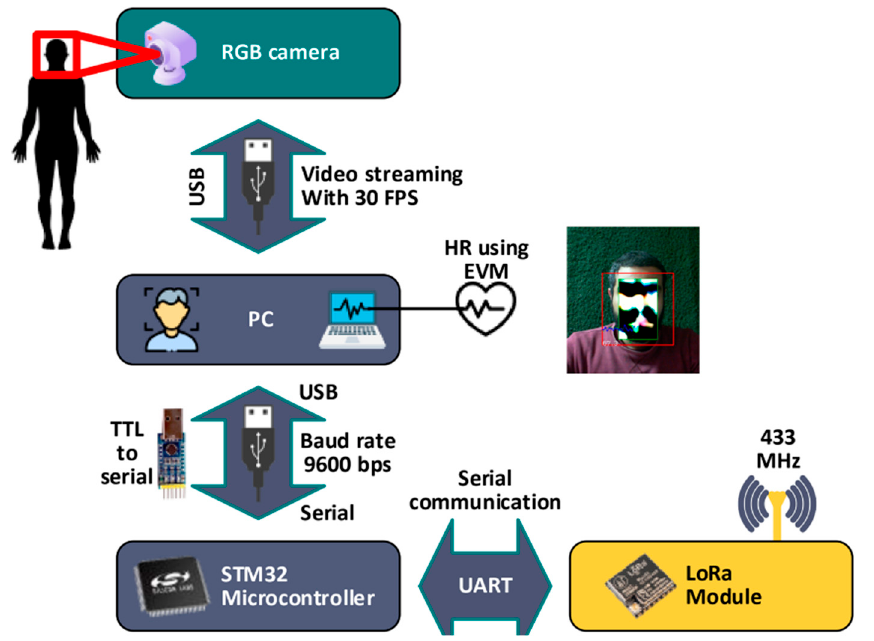
Figure 7. IoT nodes for estimating the heart rate using EVM (inspired from [30,39]).